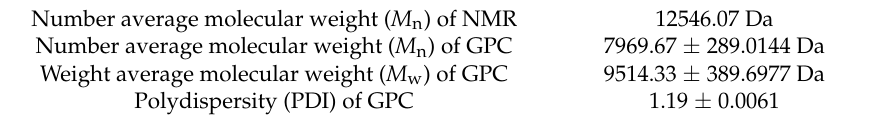
. Figure 5. 1 H NMR spectrum of ( A ) mPEG-PCL and ( B ) mPEG-PCL-COOH.